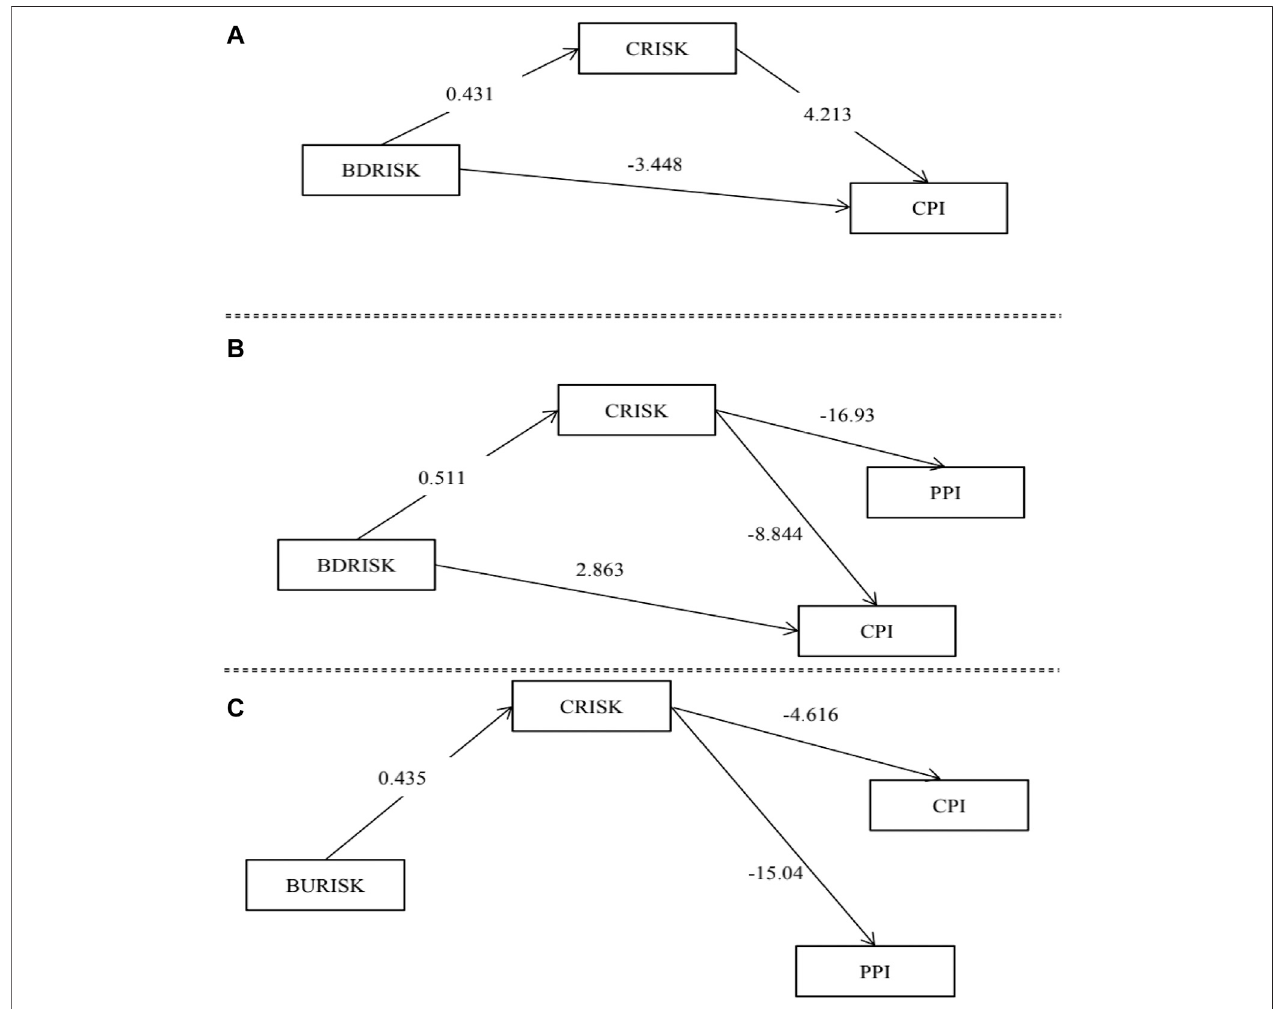
FIGURE 5 | The channel effect of commodity market risk under different returns trends. Note: (A) – (B) show the channel effect of commodity market risk in the impact of international crude oil market downward returns risk when oil commodity attribute and dual attribute dominate, respectively; (C) represents the channel effect of the commodity market risk when the dual attribute of oil dominates in the international crude oil market upward returns risk. The number on the arrow represents the impact coef fi cient.